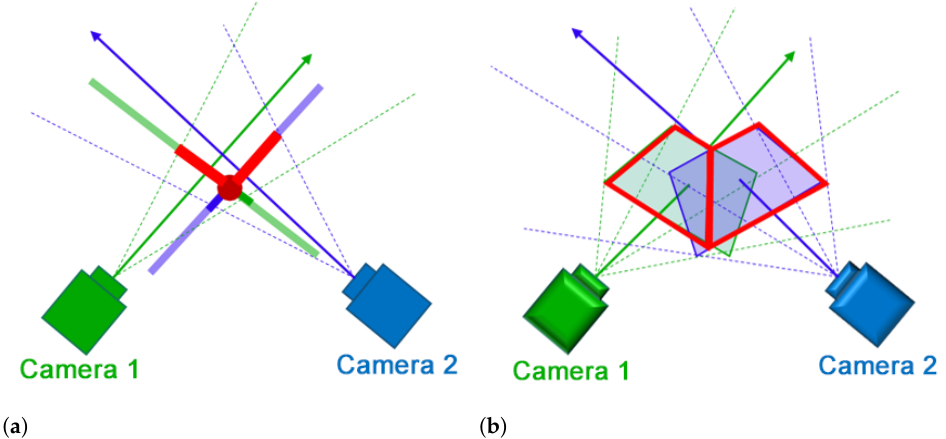
Figure 6. Constructing the expanded view using overlap area removal: ( a ) Abstract illustration of the intersection line as a red circle and the camera planes as thick red lines, and ( b ) shows the video display area after removing the overlap area as a red polygon.